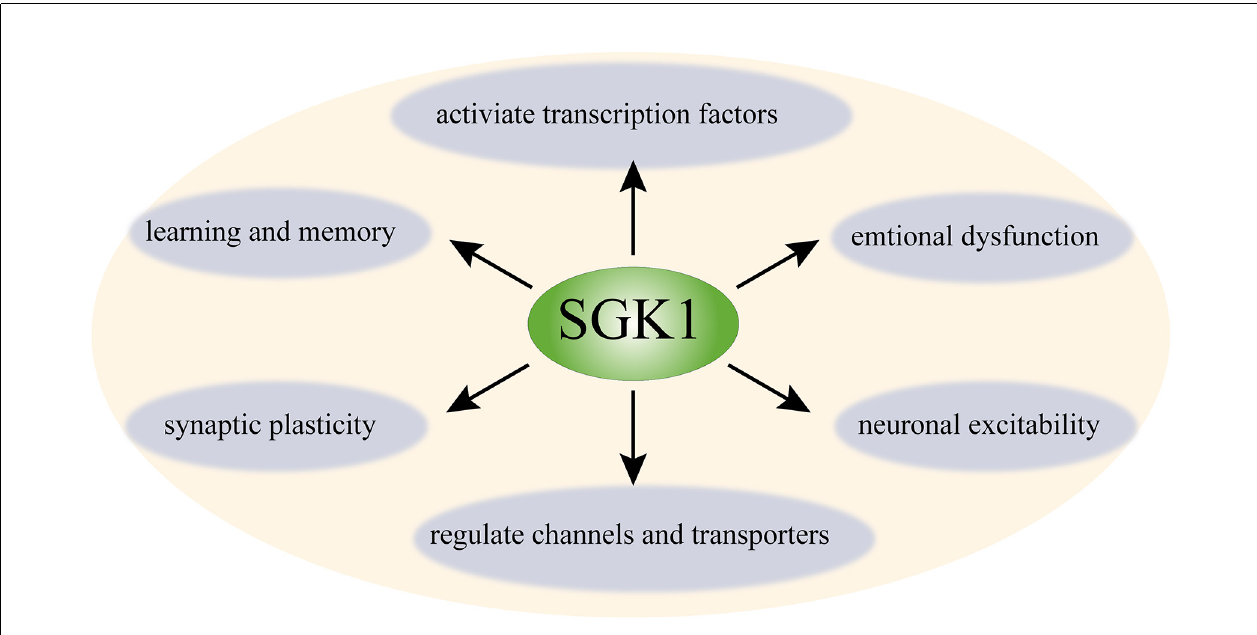
FIGURE 1 | Schematic diagram of function of SGK1 in the central nerve system. SGK1 is ubiquitously expressed in the CNS. SGK1 is considered as a regulator of transcription factors (e.g., NF- κ B, AP-1, and CREB) and several channels and transporters (e.g., ENaC, Kv1.3, TRPV5, and Kv7); it is also involved in neuronal excitability, synaptic plasticity, and learning, memory, and emotional dysfunction. SGK1, serum and glucocorticoid-inducible kinase 1; NF- κ B, nuclear factor κ -B; CREB, cAMP-responsive element-binding protein; AP-1, p53 tumor suppressor protein and activator protein-1; ENaC, epithelial sodium channel; Kv1.3,